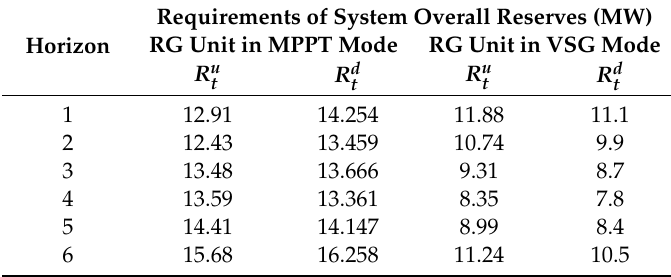
Table 6. Requirement for operating reserve capacity.